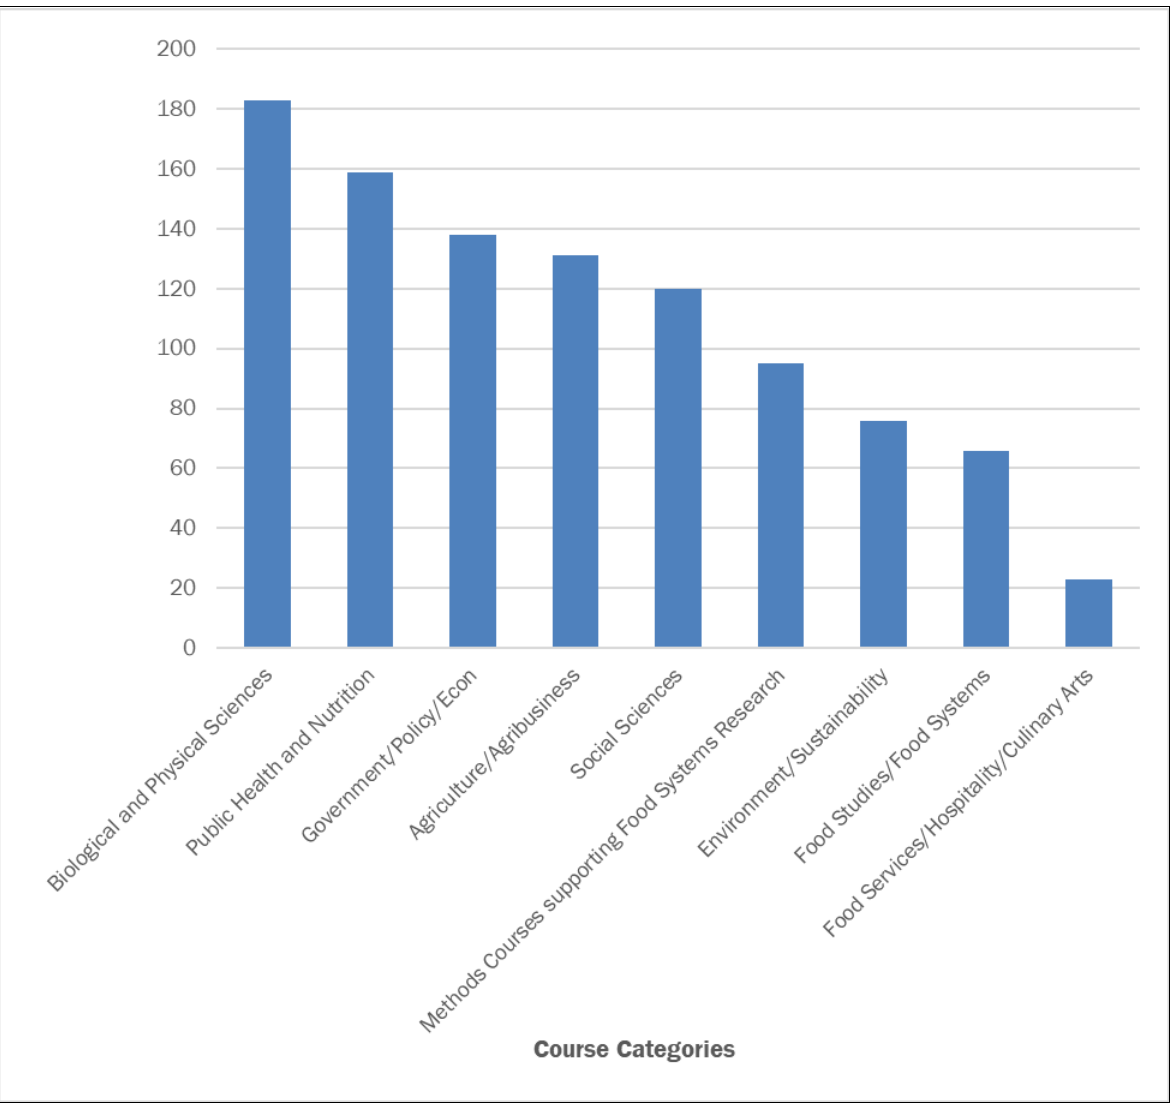
Figure 2. Interdisciplinary Food-Related Academic Graduate Program Courses by